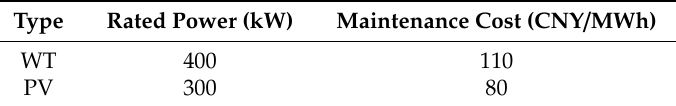
Table 10. Specification of WT and